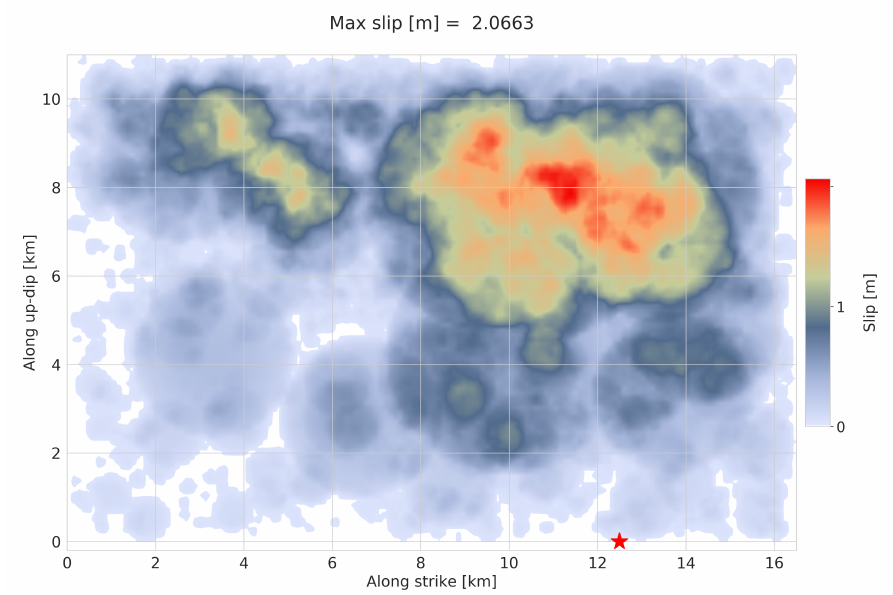
Figure 11. Maximum slip contour across the assumed fault plane. The slip patch was obtained via RIKsrf